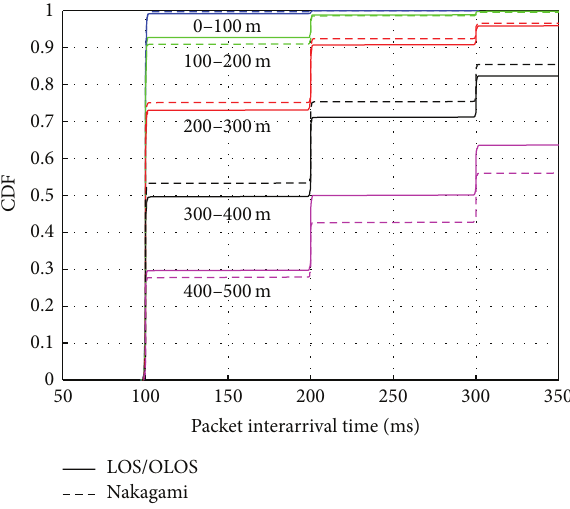
Figure 11: CDF for the packet interarrival time for a vehicle density of 40 vehicles/km for the LOS/OLOS and Nakagami models, respectively.